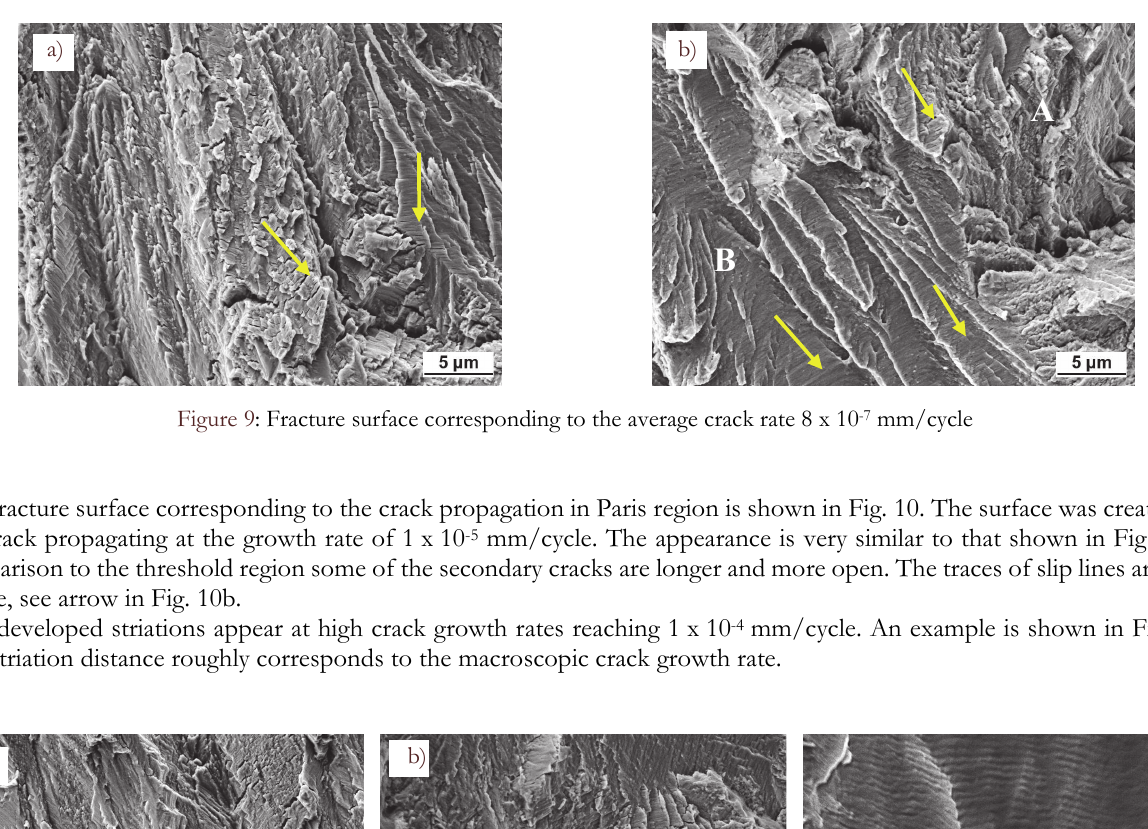
to the crack growth rate 1 x 10 -4